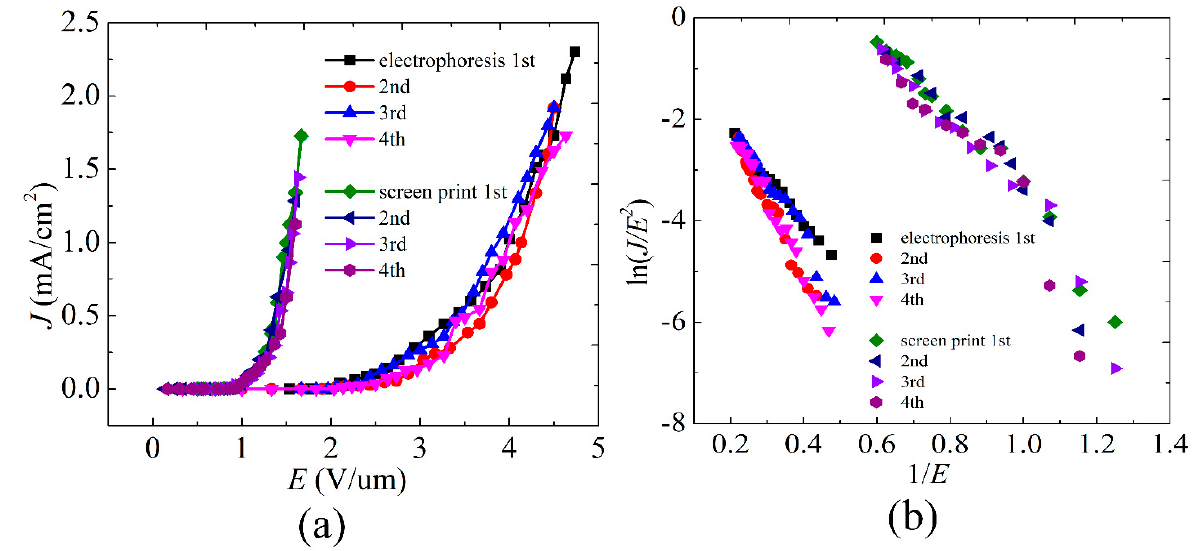
Figure 5. ( a ) The J-E curves of the screen-printed and electrophoretic SWCNT cathodes. ( b ) The corresponding F-N plots. Table 1. Repetition tests of the screen printed and electrophoretic SWCNT cathodes.